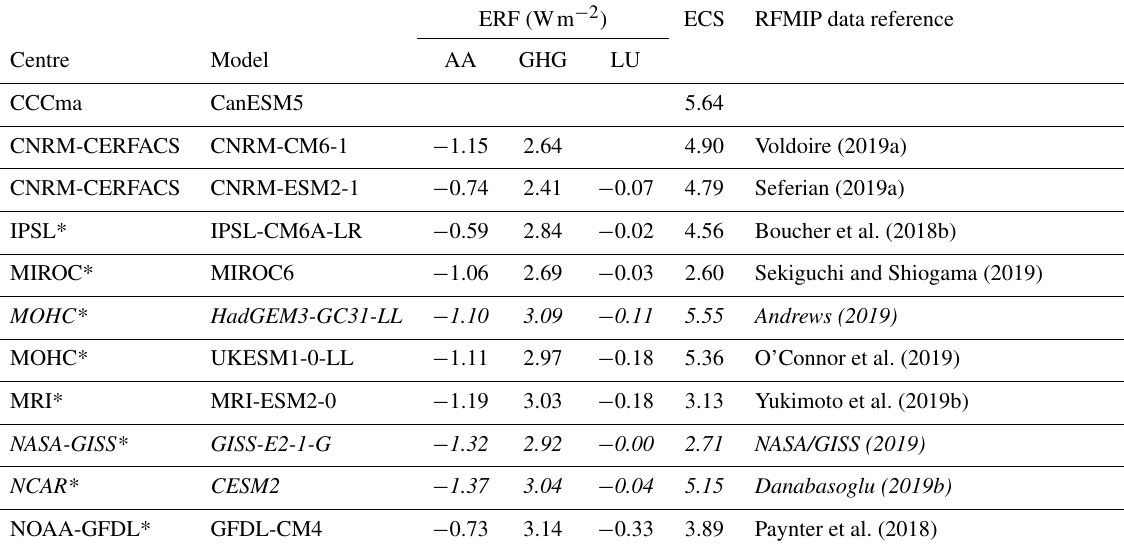
Table 2. Historical effective radiative forcing (ERF), calculated from RFMIP sstclim experiments, and equilibrium climate sensitivity (ECS) from Zelinka et al. (2020).